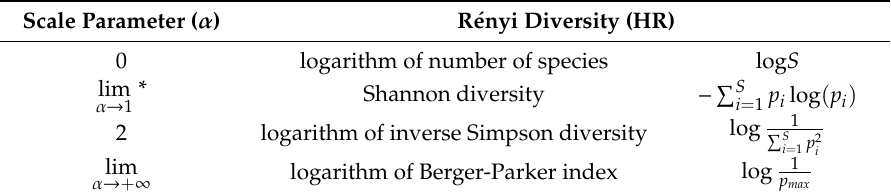
* Scale parameter cannot take the exact value of 1, but its limit as α tends to